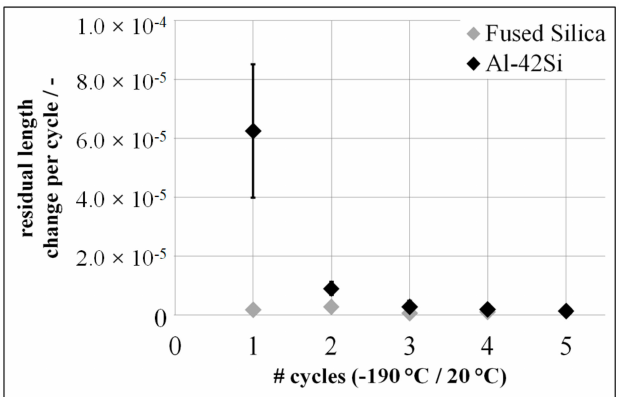
Figure 6. Residual length change of Fused Silica and Al-42Si in a temperature range between − 190 ◦ C and 20 ◦ C.